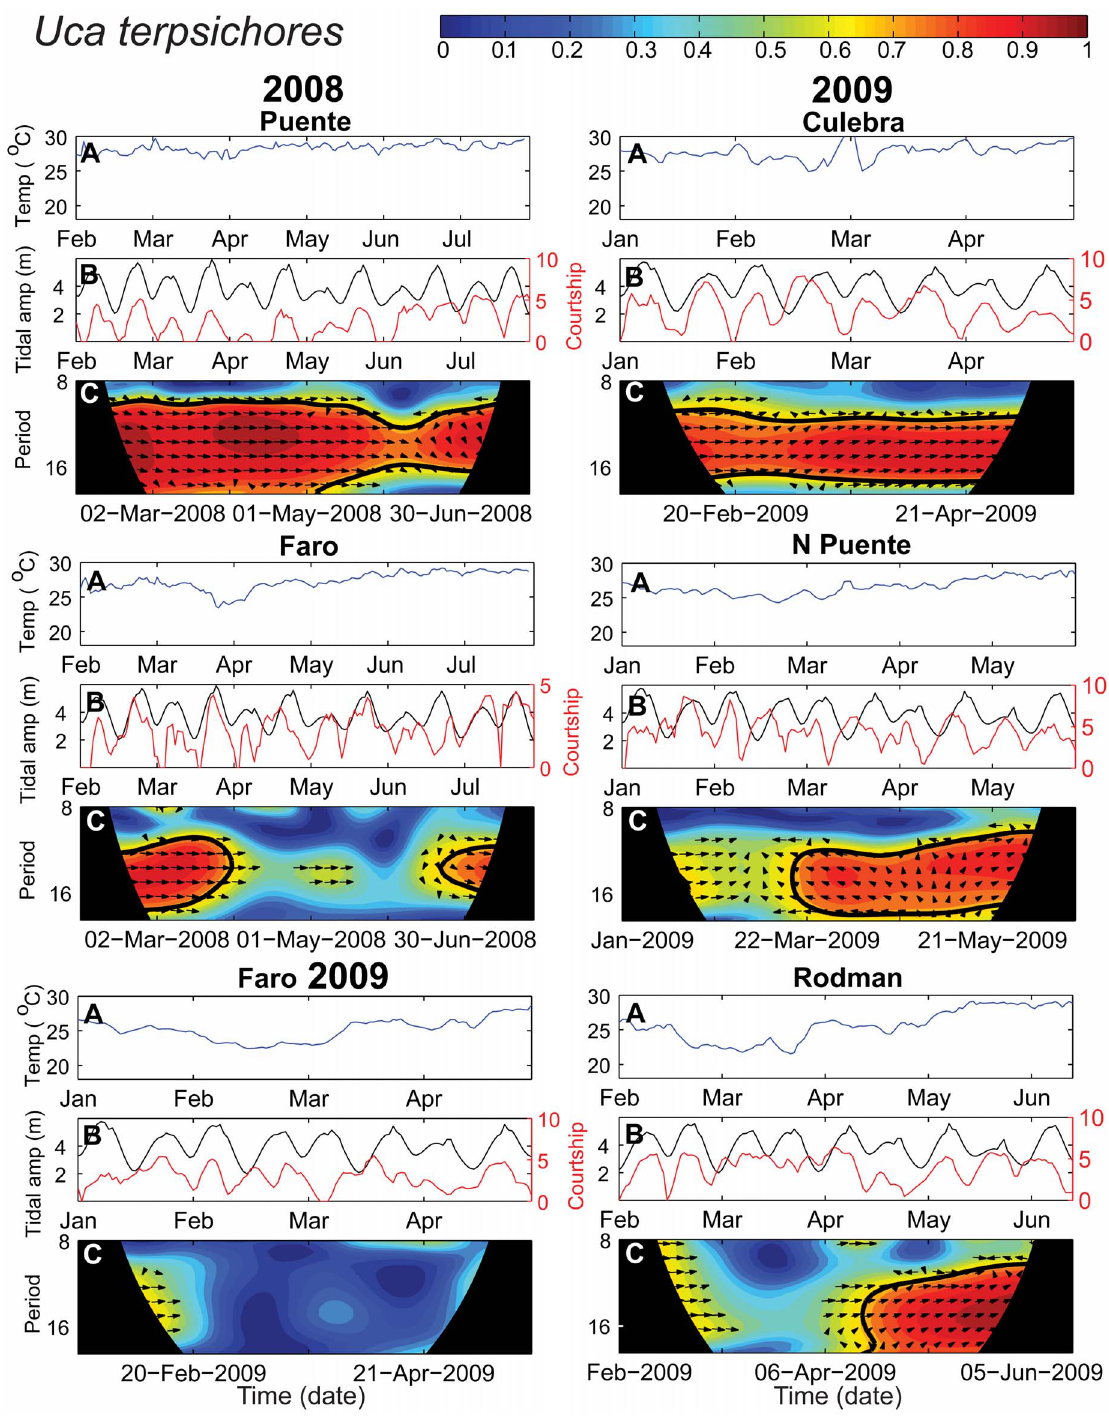
Figure 4. Temperature, tidal amplitude and Ucaterpsichores courtship intensity. Wavelet coherence results for U. terpsichores for two sites in 2008 and four sites in 2009. See the Figure 3 caption for an explanation of the panels A, B and C. Only the period lengths (y-axis) of approximately one tidal amplitude cycle (12–17 days), the area of interest, and a buffer of a few days on either side are shown in plot C. doi:10.1371/journal.pone.0097593.g004 P species ,, 0.001, F species*temp = 8.71, P species*temp =0.004). The slight temporal shift in courtship by U. deichmanni was thus, significantly smaller than the shift observed for U. terpsichores , and was not resolved by our wavelet analysis.